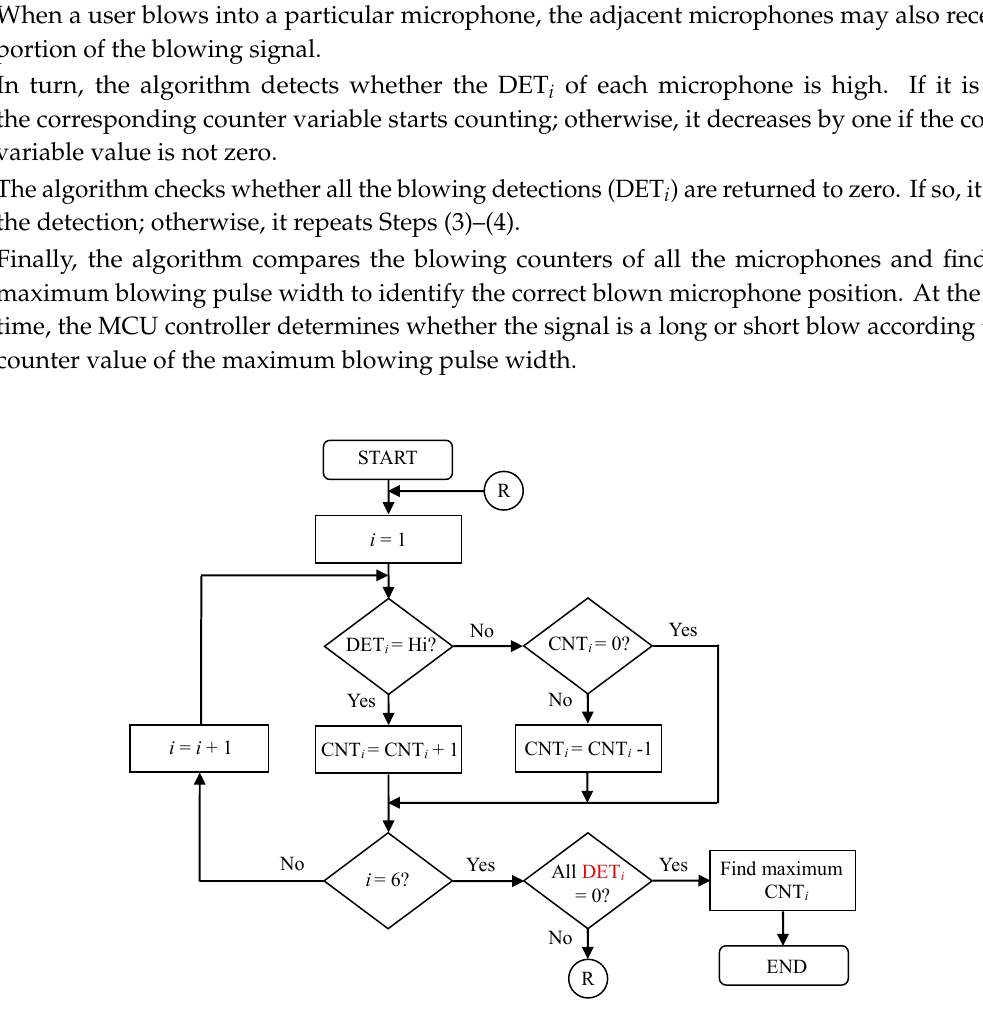
Figure 5. The identification algorithm for finding the maximum blowing pulse width.